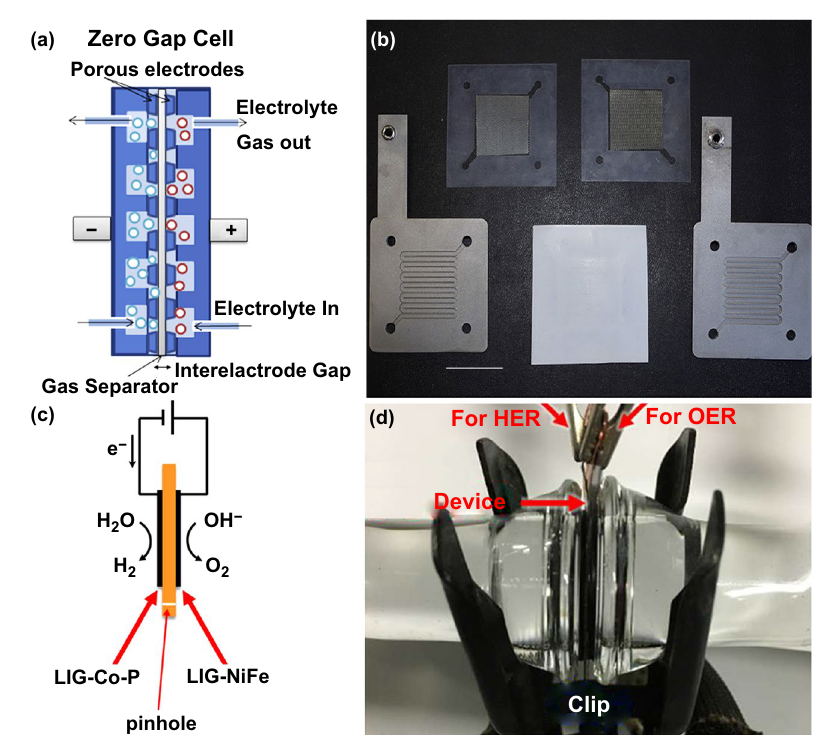
Fig. 4 a Schematic diagram for reducing the gap between electrodes by using a zero-gap cell, b components for the zero-gap cell, including the machined flow field plates, silicone gaskets, mesh electrodes and Zirfon gas separator. Reproduced with permission from Ref. [70]. Copyright 2017 Elsevier Inc., c schematic diagram and d a photograph of an integrated LIG electrolyzer. Reproduced with permission from Ref. [72]. Copyright 2017 American Chemical